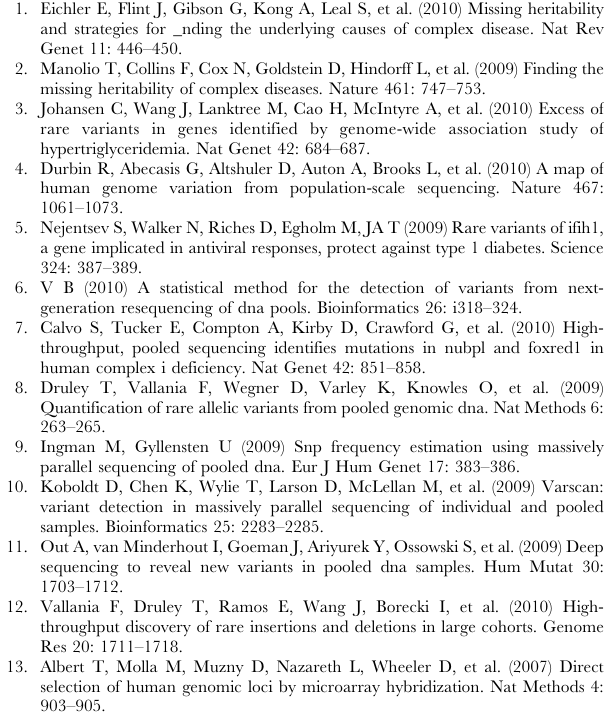
Table S29 Pool of 20 technical replicate variant overlap after duplicate removal. For the PCR and aHC technical replicates for the pool of 20 this table details the total number of variants called for each replicate, the number of variants called by replicates, the average absolute difference in non-reference allele frequency for the overlapping variants, and the Pearson’s correlation coefficient for the non-reference allele frequency estimates between the replicates. The average absolute